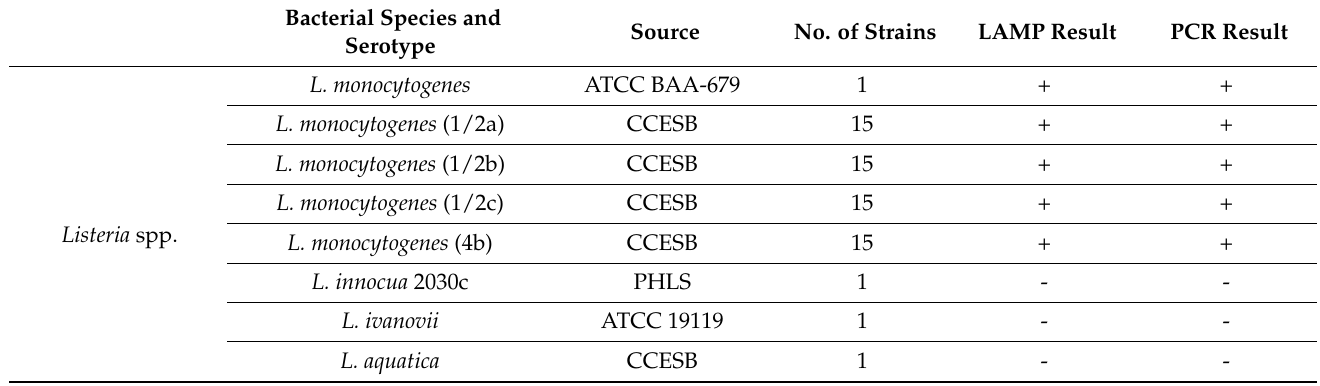
Table 1. Bacterial strains used for LAMP evaluation and PCR